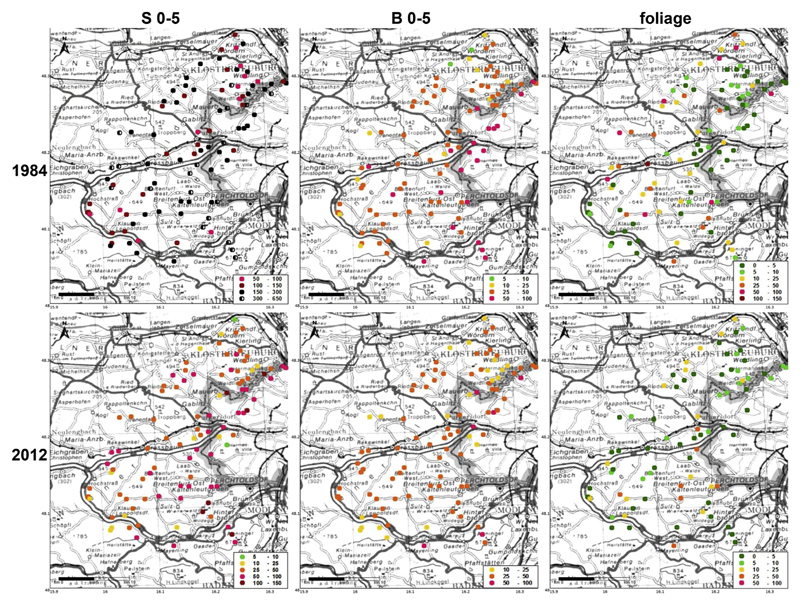
Geographical distribution of top soil Pb contents in the infiltration zone of stemflow (S 0–5; left) and the between trees area (B 0–5; middle), as well as foliar Pb contents (right), sorted by classes (mg kg−1), in beech stands of the Vienna Woods in 1984 (top) and 2012 (bottom).